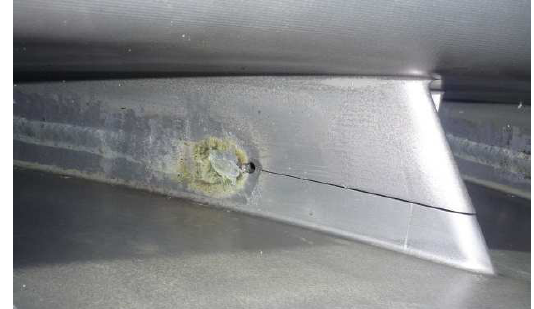
Fig. 4. An example of a technological hole .